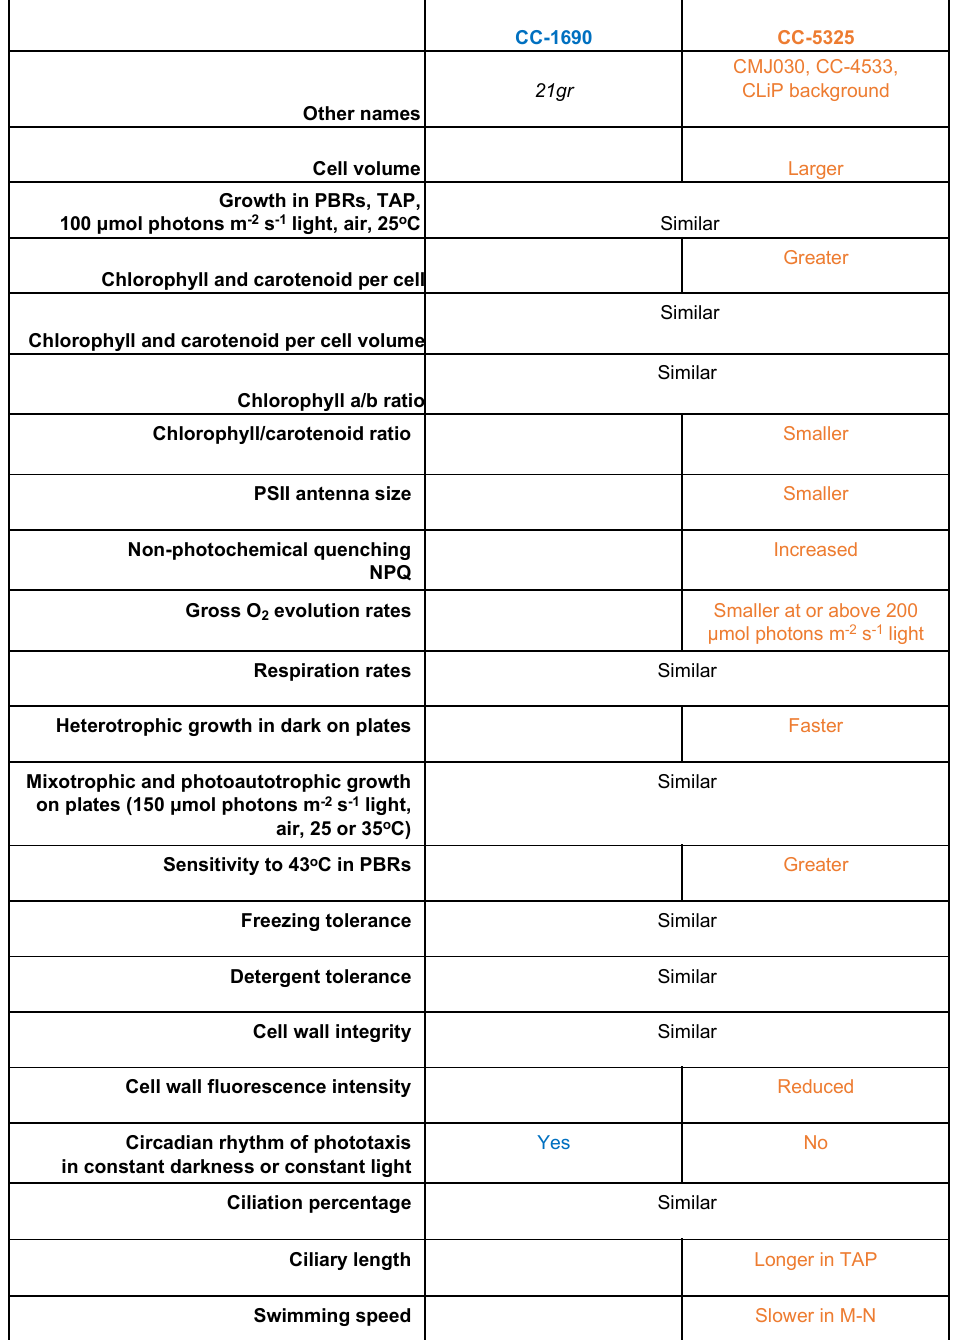
Figure 11. Summary of phenotypic differences between CC-1690 and CC-5325. TAP, Tris-acetate- phosphate medium. M-N, minimal medium without nitrogen and acetate. The phenotypic descrip- tions for CC-5325 are in comparison to CC-1690.